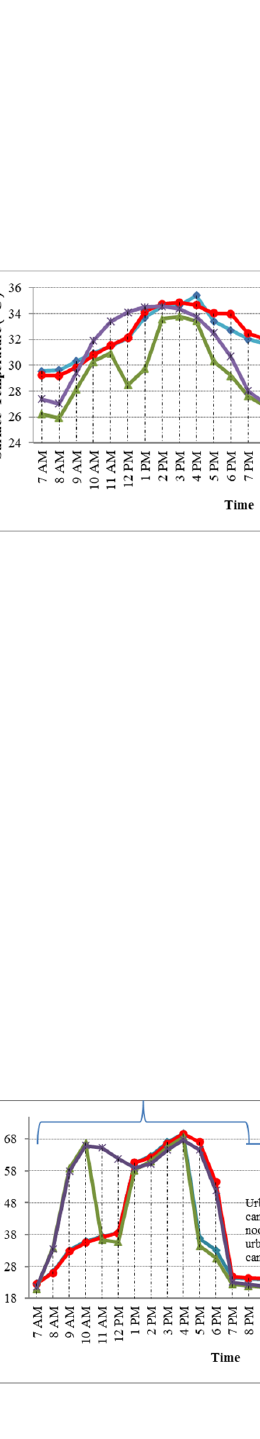
Figure 9. The validation between measured and simulated temperature ( left ) and RH ( right ) at SM.